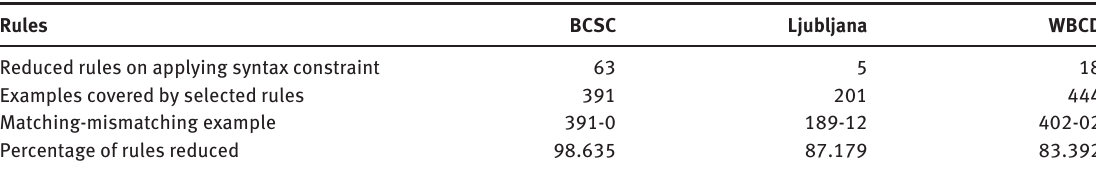
Table 5: Number of Syntax-based Reduced Association Rules Obtained for All Three Breast Cancer Data Sets Used for Feature Selection.